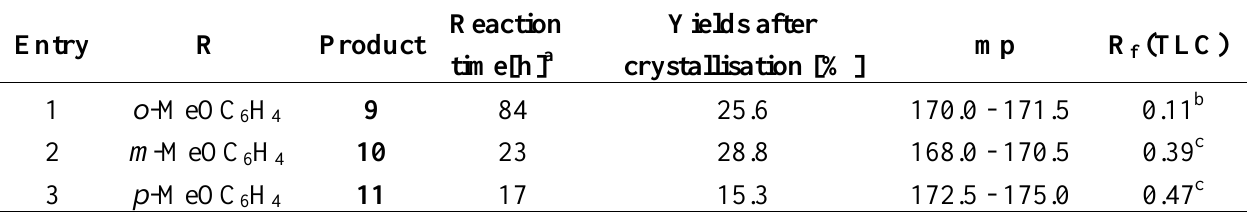
Table 1. The results of Hantzsch condensation of ( o -, m - and p )-methoxybenzaldehydes 5 - 7 with methyl-3-aminocrotonate ( 8